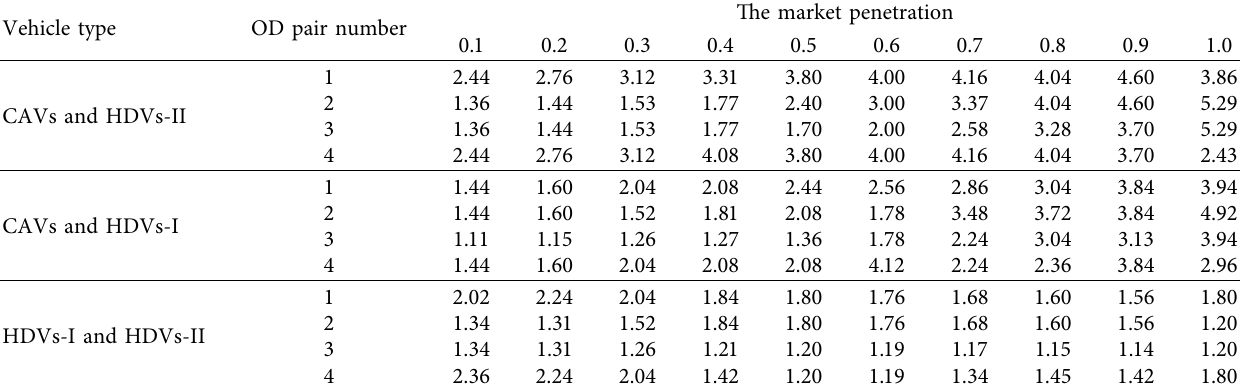
indicating the market penetration distribution of CAVs and HDVs-I, numbered in order from top to bottom and